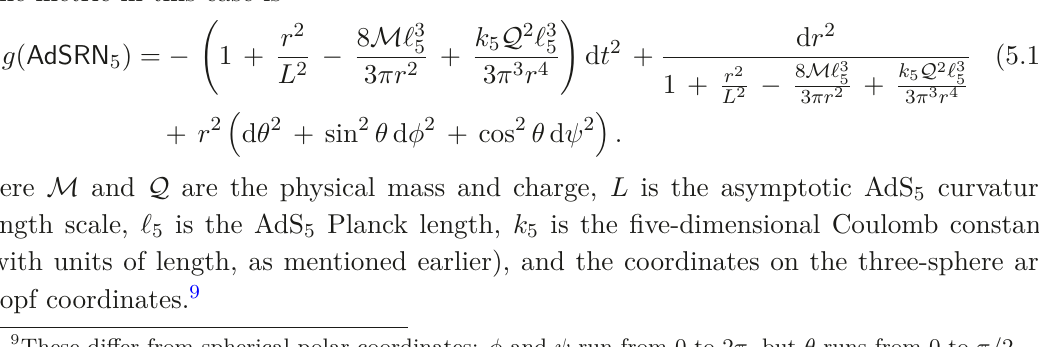
JHEP02(2023)072